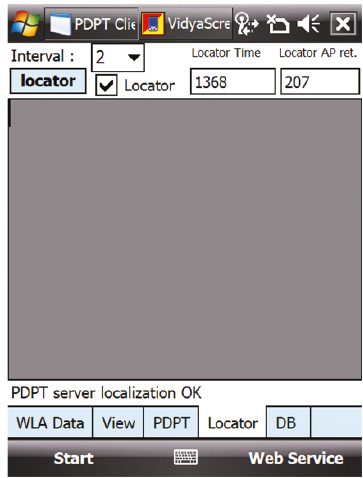
Figure 6: PDPT Client. On Locator tab is possible to set an interval for scanning of WiFi network neighbour. Locator time displays a real interval between a sending of neighbour WiFi AP summary and the reply from server.